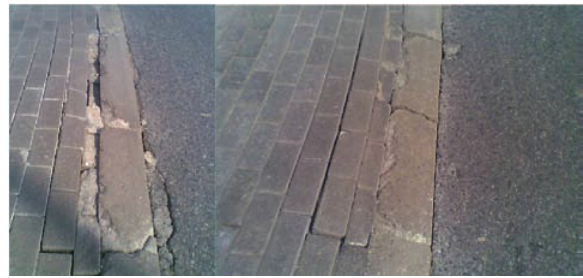
Fig. 12. Characteristic damages of road kerbs